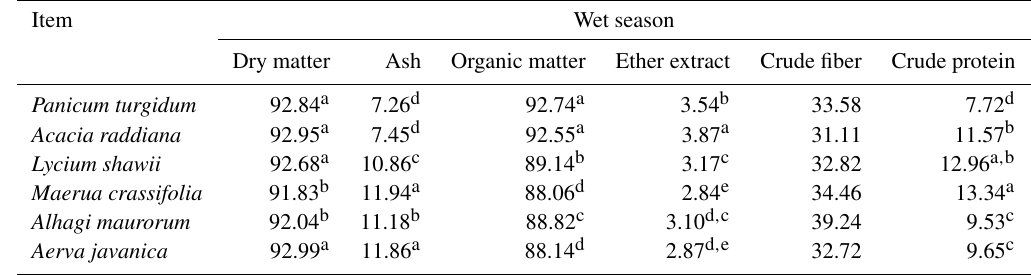
Table 2. Chemical composition of rangeland plants at Halaieb study area during the wet season (%, dry matter basis).